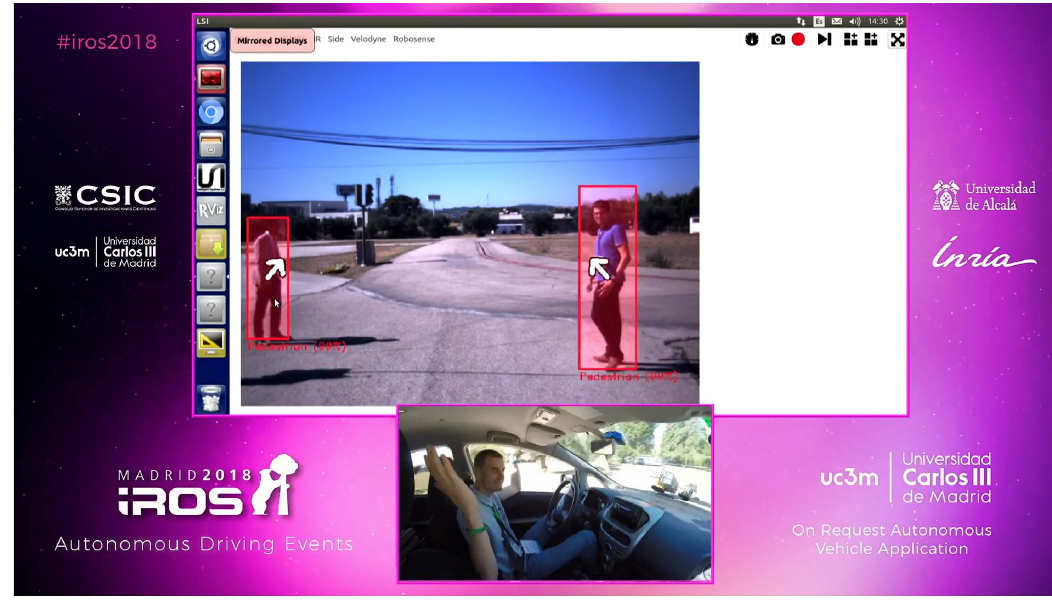
Figure 15. IROS18 autonomous driving